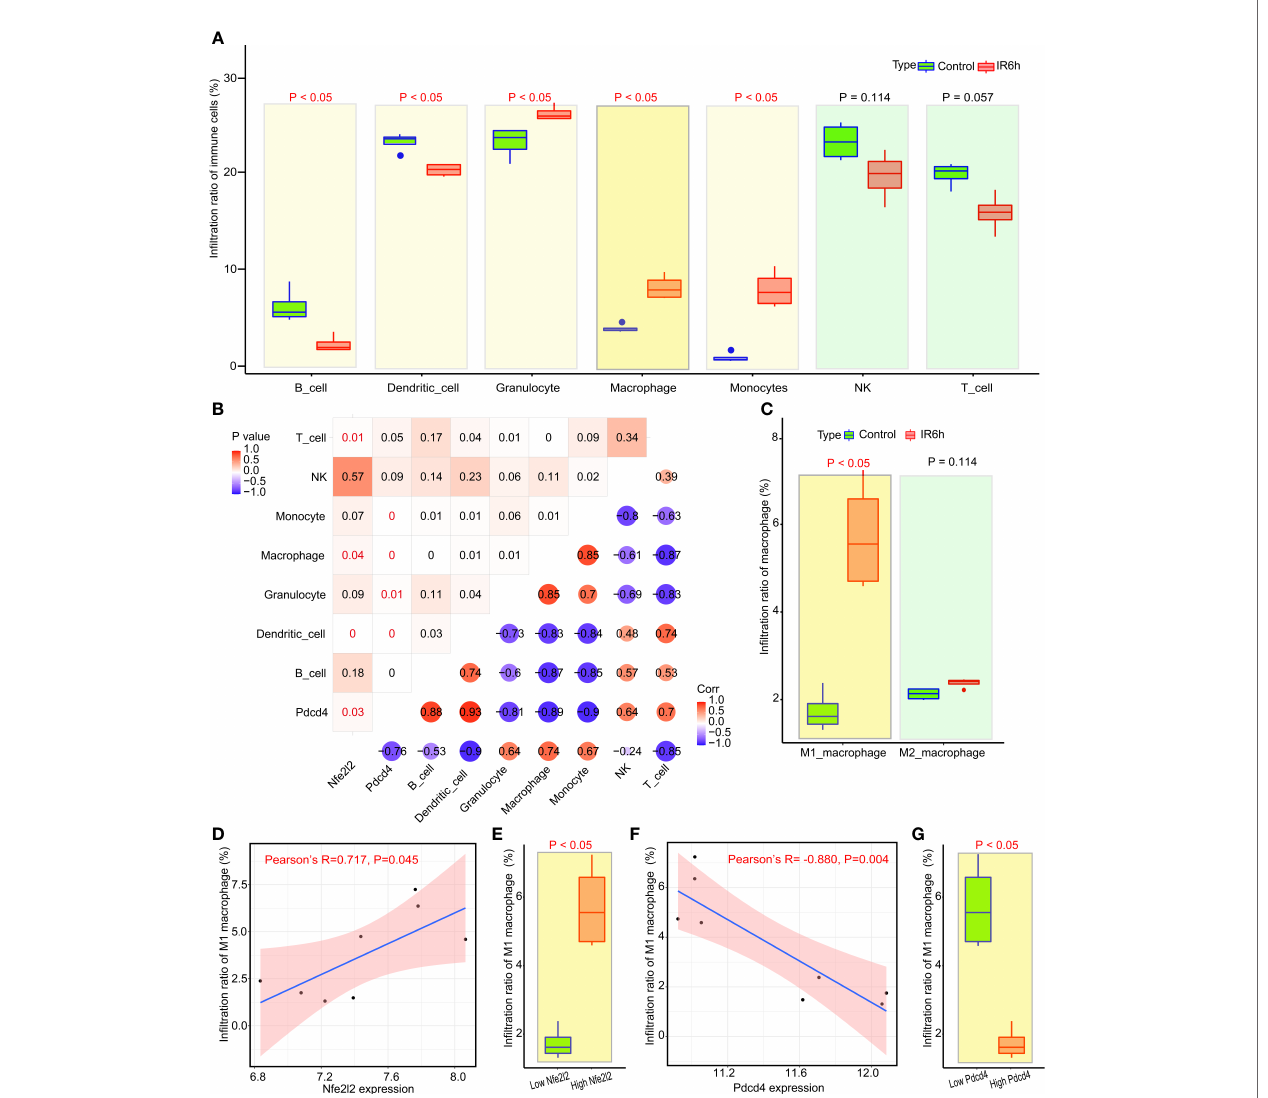
FIGURE 2 | Nrf2 cooperated with Pdcd4 to promote in fi ltration of M1 macrophages. (A) Analysis of immune cell in fi ltration by ImmuCellAI. (B) Correlation analysis among seven categories of immune cells, Nfe2l2 and Pdcd4. The P-value is in the upper left corner; the corresponding Pearson correlation coef fi cient is in the lower right corner. (C) Subtype analysis of macrophages using ImmuCellAI. (D) Correlation analysis between M1 macrophages and Nfe2l2 expression. (E) Analysis of in fi ltrated M1 macrophages between the low Nfe2l2 and high Nfe2l2 groups. (F) Correlation analysis between M1 macrophages and Pdcd4 expression. (G) Analysis of in fi ltrated M1 macrophages between the low PDCD4 and high PDCD4 groups. ImmuCellAI, immune cell abundance identi fi